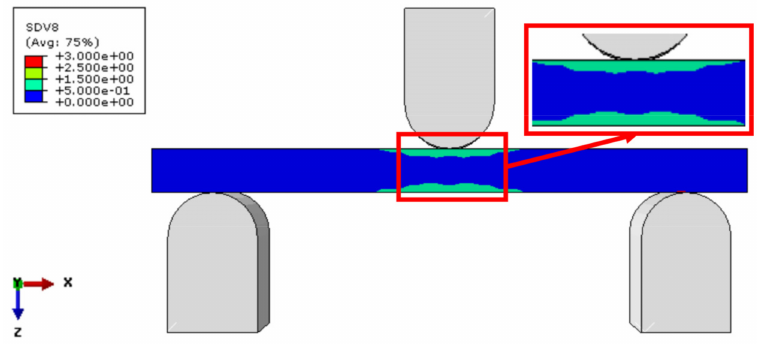
Figure 12. Damage mode factors on the sample surface.